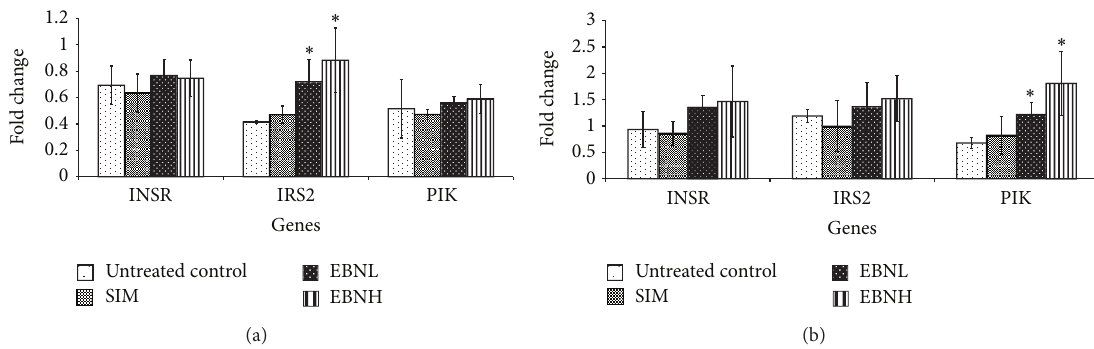
Figure 5: Effects of edible bird’s nest (EBN) on (a) hepatic and (b) adipose tissue mRNA levels of insulin receptor (Insr), insulin receptor substrate (Irs) 2 and Phosphoinositide-3-kinase (PI3K) in high fat diet- (HFD-) fed rats. Groupings are similar to Figure 2. ∗ indicates significant difference ( 𝑃 < 0.05 ) in comparison with untreated control.